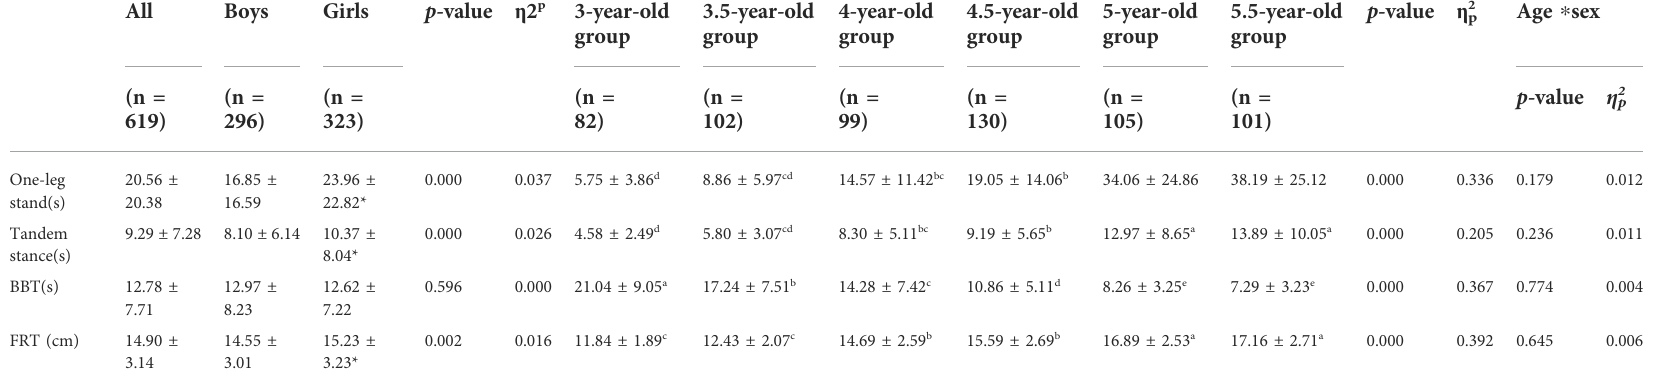
TABLE 2 The results of balance performance according to sex and age. All